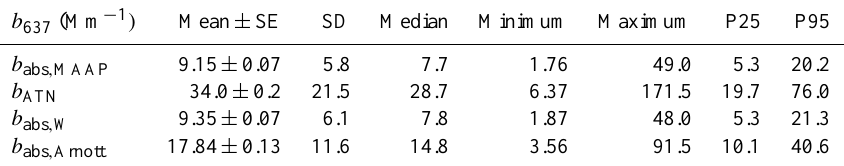
Table 2. Statistics of MAAP and Aethalometer compensated and non-compensated absorption coefficients at 637nm: mean standard error, standard deviation, median, maximum, minimum, 25th percentile, and 95th percentile. MAAP corresponds to b abs , MAAP statistics; b ATN corresponds to non-corrected Aethalometer data; b abs , W corresponds to data compensated as proposed by Weingartner et al. (2003); and b abs , Arnott represents data compensated with the algorithm and compensation factors ( M and α ) from Arnott et al. (2005). b 637 (Mm − 1 ) Mean ± SE SD Median Minimum Maximum